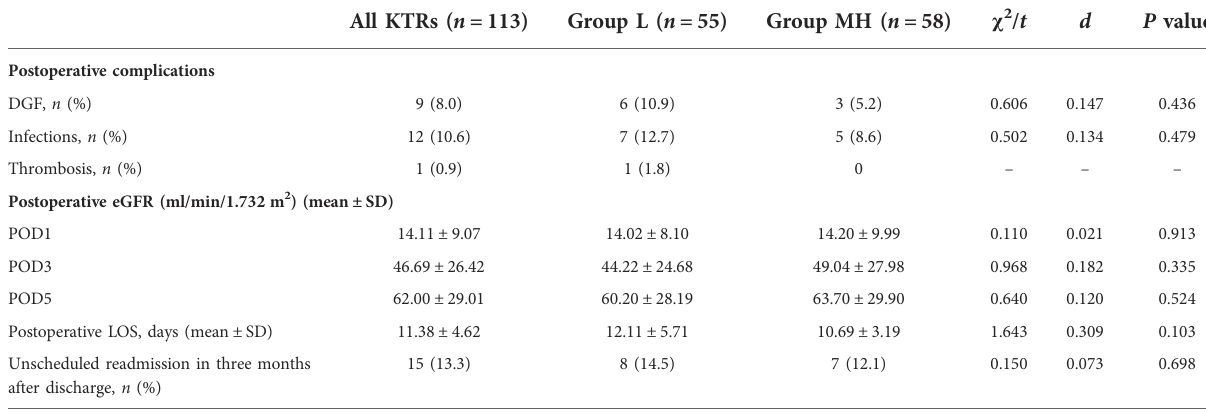
TABLE 3 Postoperative recovery of KTRs ( n